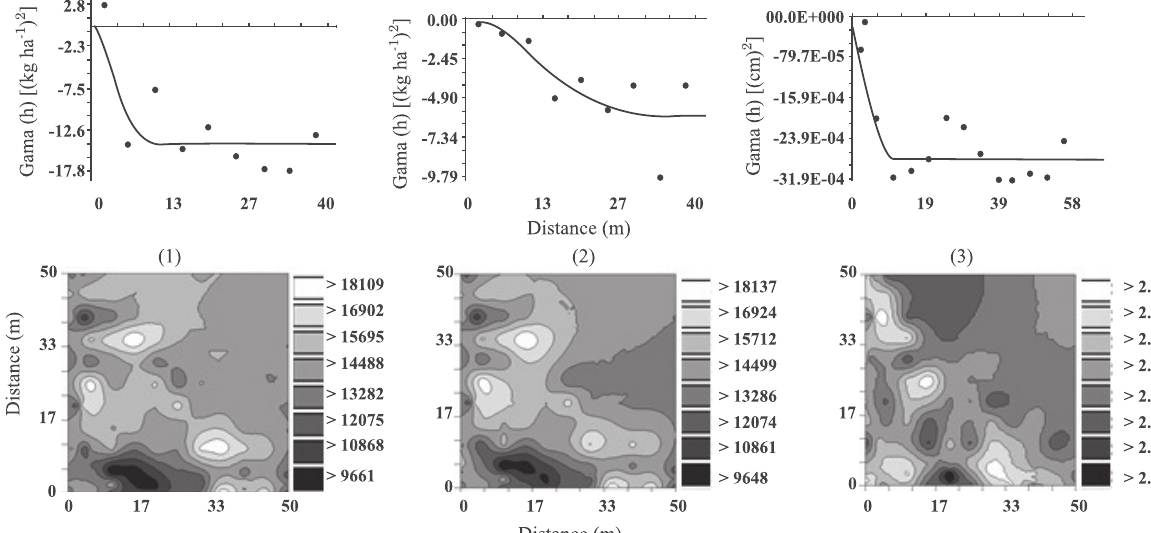
Figure 3. Cross-semivariograms and kriging maps for some properties of corn forage productivity and soil physical properties of a dystrophic red latosol. 1) Forage dry matter vs microporosity in layer 0-0.10 m, 2) Forage dry matter vs total porosity in layer 0.10-0.20 m, 3) Stem diameter vs bulk density in layer 0-0.10